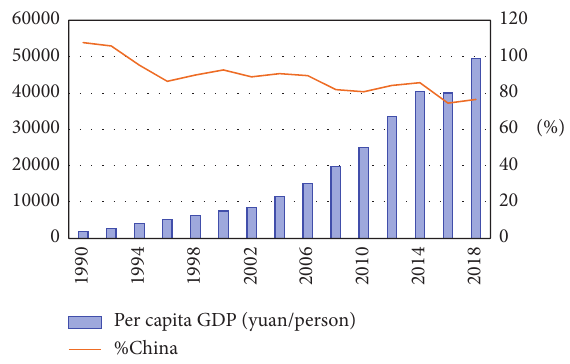
Figure 2: The growth of per capita GDP and ratio to the national average in Xinjiang,